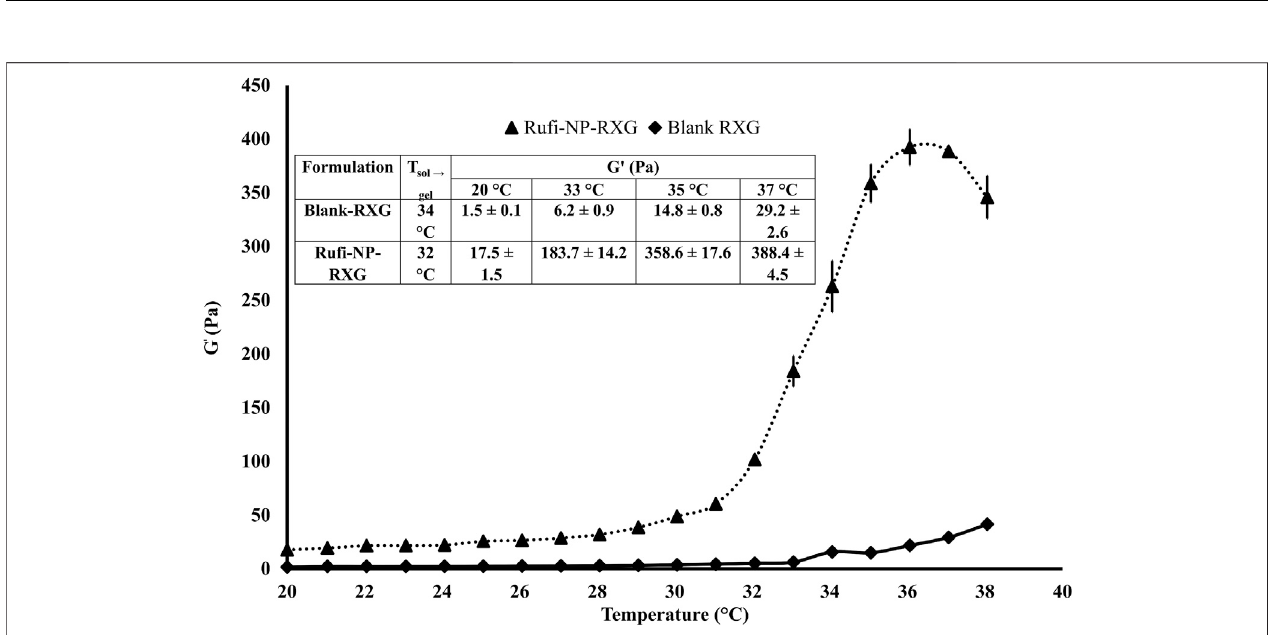
FIGURE 3 | Rheological evaluation for Ru fi -NP-RXG and Blank-RXG using temperature sweep. Note: Analysis for each formulation was performed in triplicate. Each data point is represented as mean ± SD of n (cid:2) 3 determinations.